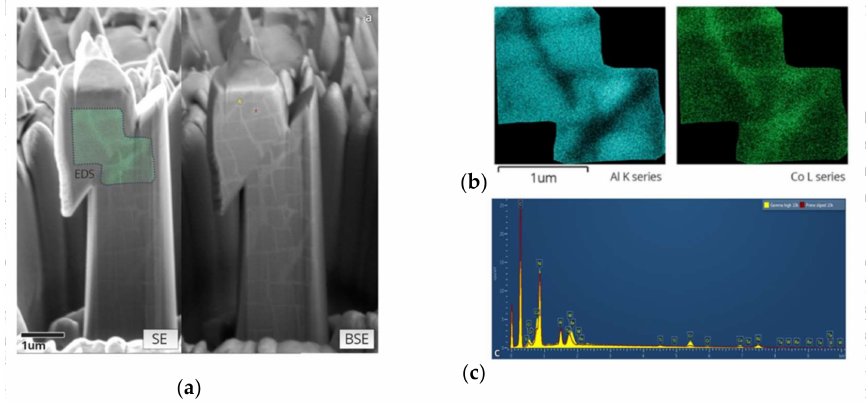
Figure 7. FIB–SEM tomography and EDS results: ( a ) a FIB-milled vertical section of a pillar after compression in both secondary electron (SE) and backscattered electron (BSE) detectors (55 ◦ tilt), featured by one slip burst; ( b ) EDS results shows phase contrast by Al and Co mapping, on a selected area indicated on the SE image; ( c ) comparison of EDS spectrum of the typical γ and γ ’ phase, indicated on the BSE